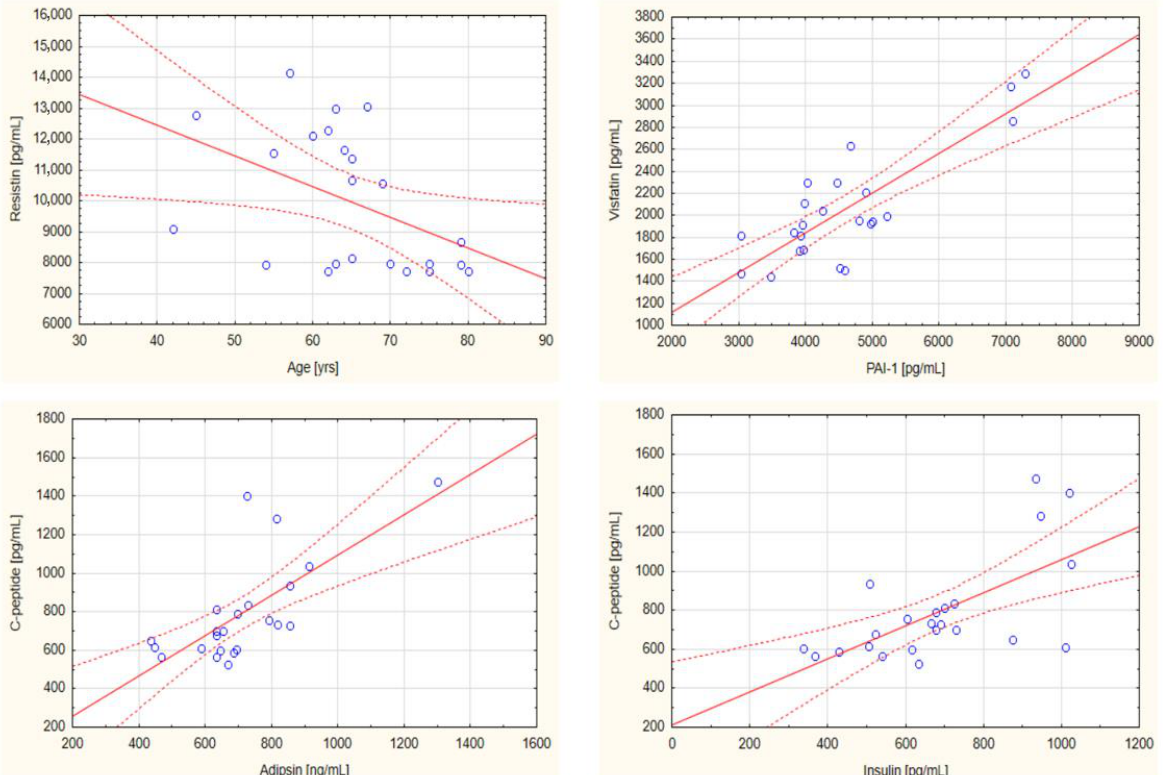
Figure 2. Statistically significant correlations between selected biochemical parameters in the in- creased body mass index group of head and neck cancer patients. Abbreviations used: PAI-1: plas- minogen activator inhibitor-1. The regression line is marked with a solid line, while the confidence intervals of 0.95 are marked with a dashed line. P < 0.05 was considered as statistically significant. (nBMI vs. iBMI and nBMI vs. control group) and men (nBMI vs. iBMI and nBMI vs. control